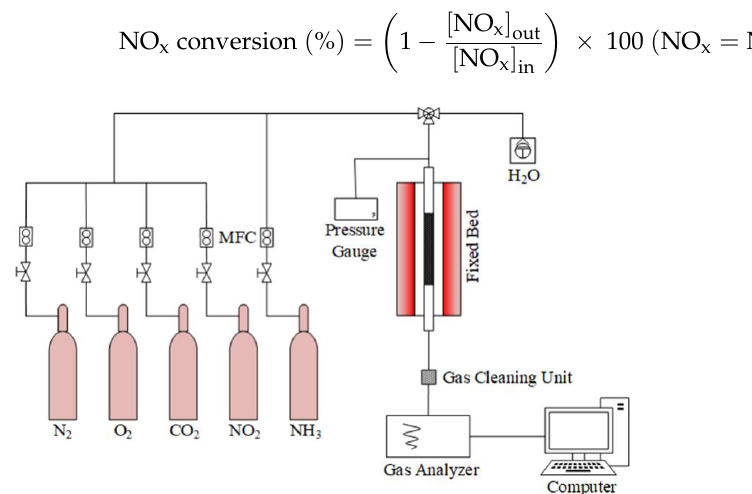
Figure 2. Schematic diagram of the experimental apparatus for catalytic performance.